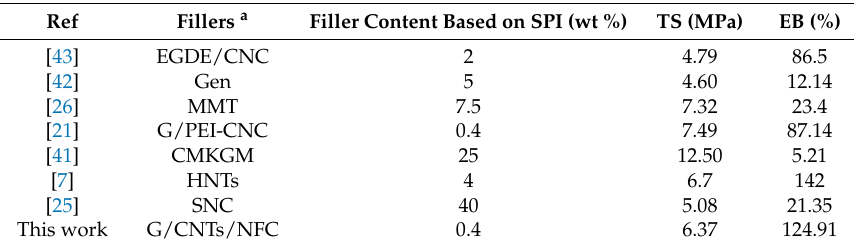
Table 3. Comparison of TS and EB of SPI/G/CNT/NFC nanocomposite film with other SPI-based composite films in previous literature.